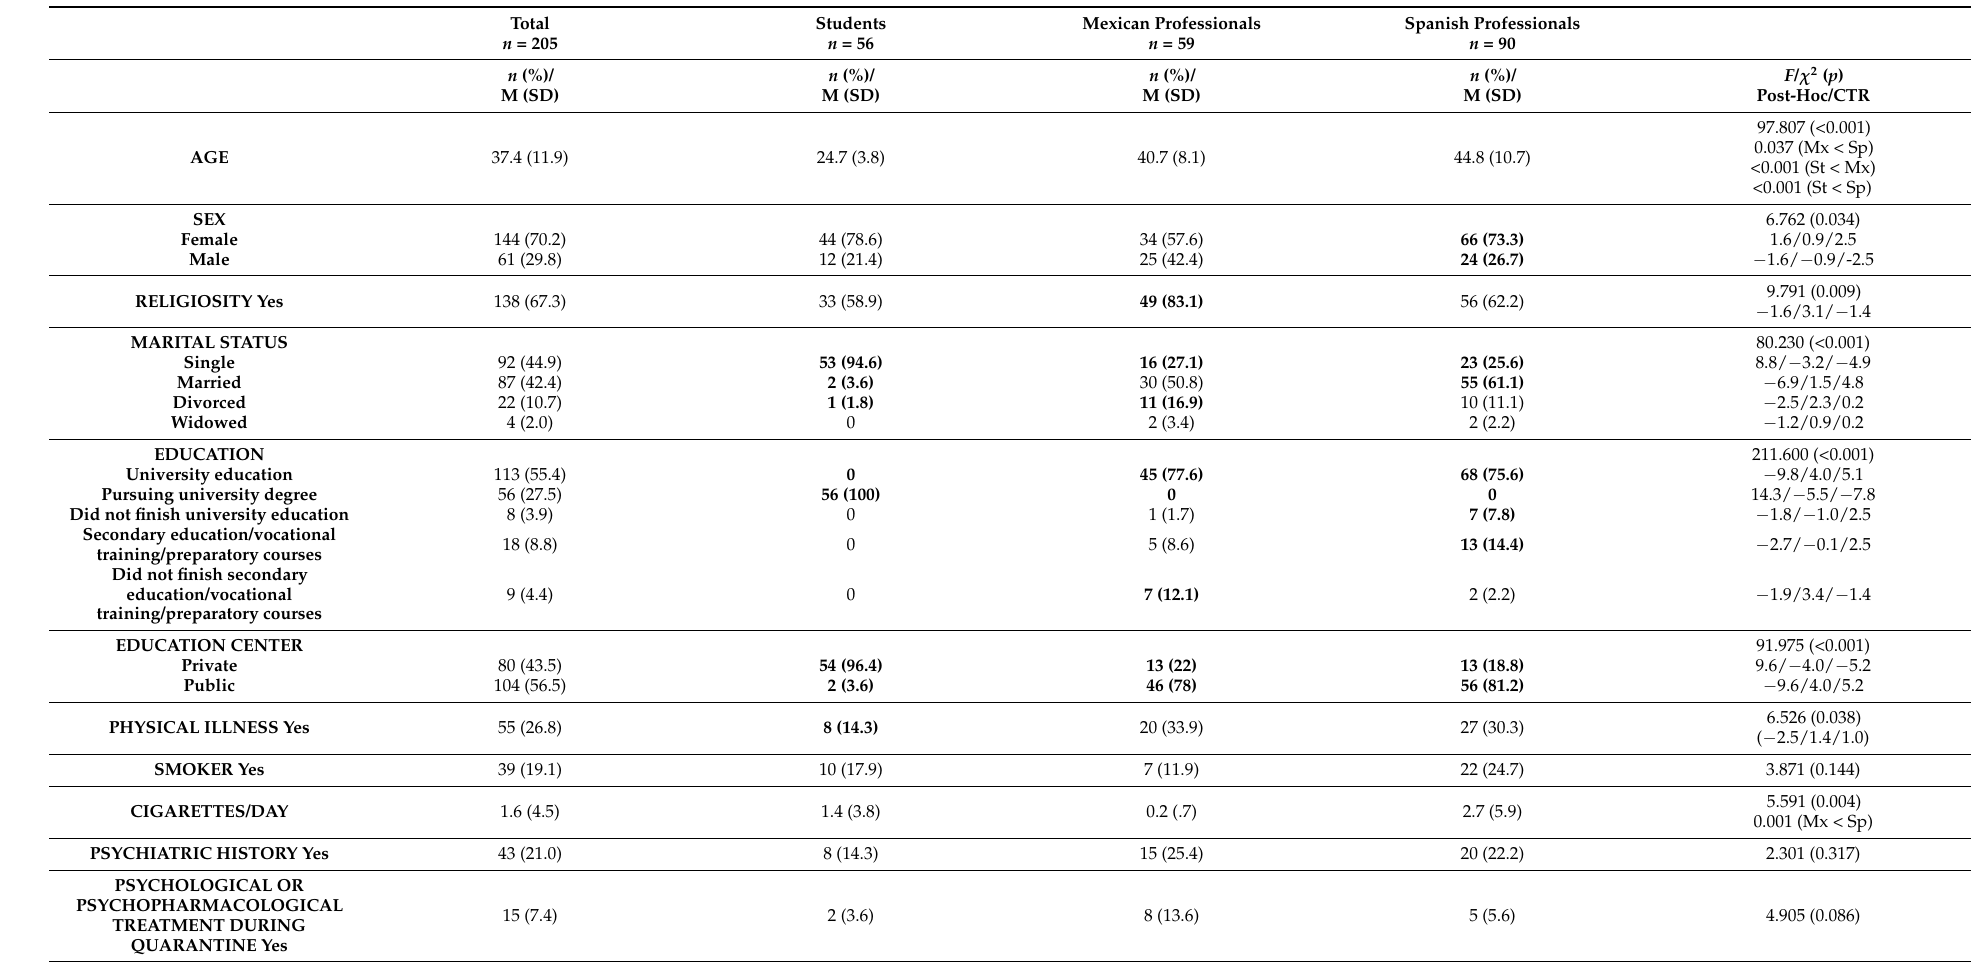
Table 1. Sociodemographic characteristics and differences between the study